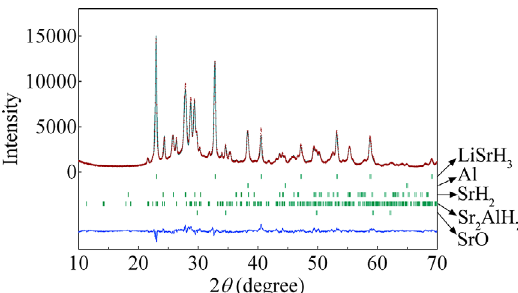
Figure 5. Rietveld refinement of the XRD pattern for the as-milled AlH + LiNH mixture dehydrogenated at 330 °C. The vertical Sr 2 7 2 bars (from above) indicate the positions of Bragg diffraction for LiSrH , Al, SrH , Sr AlH and SrO, respectively. (The reliability 3 2 2 7 factors for refinement are R = 5.81%, R = 4.59% and S = wp p